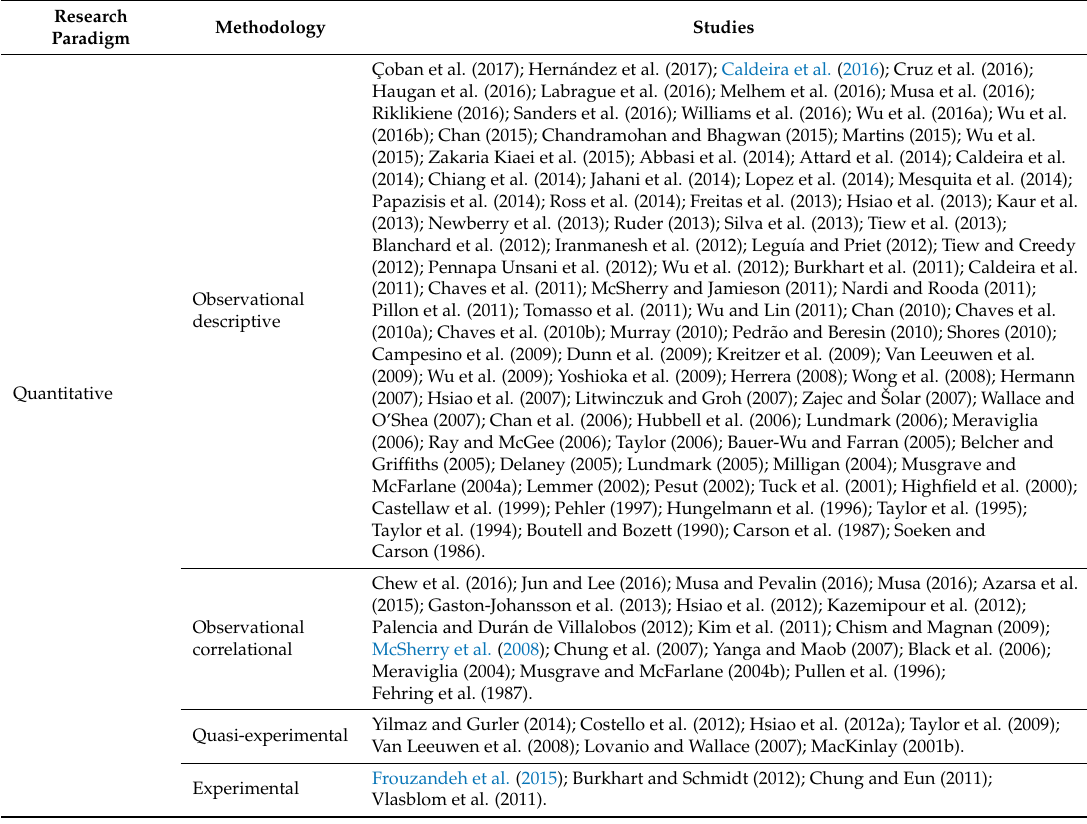
Table 3. Research paradigm and methods of results in this